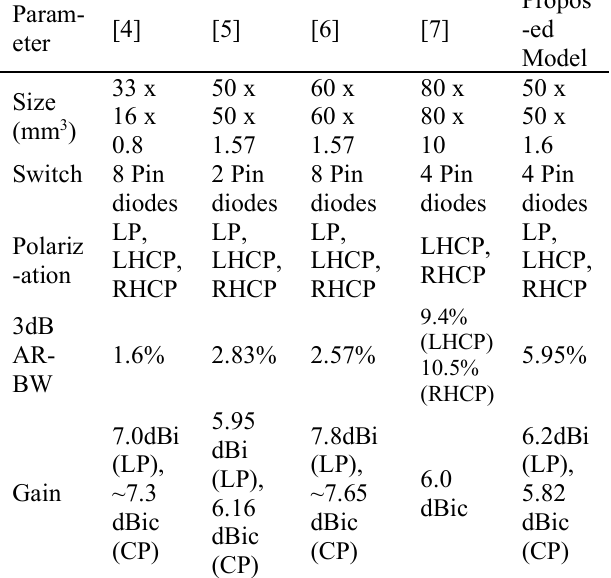
Table 2: Performance Comparison of proposed antenna